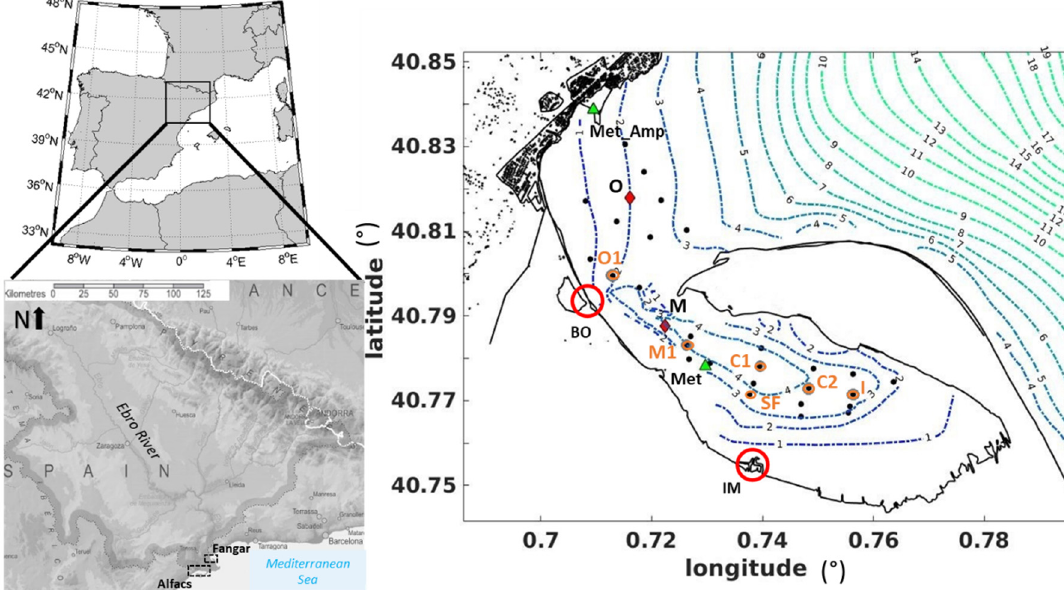
Figure 1. Location of the study area. The red circles show the two main points of freshwater discharges (Bassa de les Olles (BO) and Illa de Mar (IM)), the red diamonds show the two mooring locations during the field campaigns (M: Mouth; O: Out of the bay), and the green triangle shows the location of the meteorological station (Met and Met_Amp). The black point shows the Conductivity, Temperature, and Depth (CTD) profile, the black points surrounded by an orange circle as well as the orange letters (M: Mouth; C: Central; SF: Selfish Farms; I: Interior) are the chlorophyll a (Chl a ) water sampling stations and the blue lines show the bathymetry.